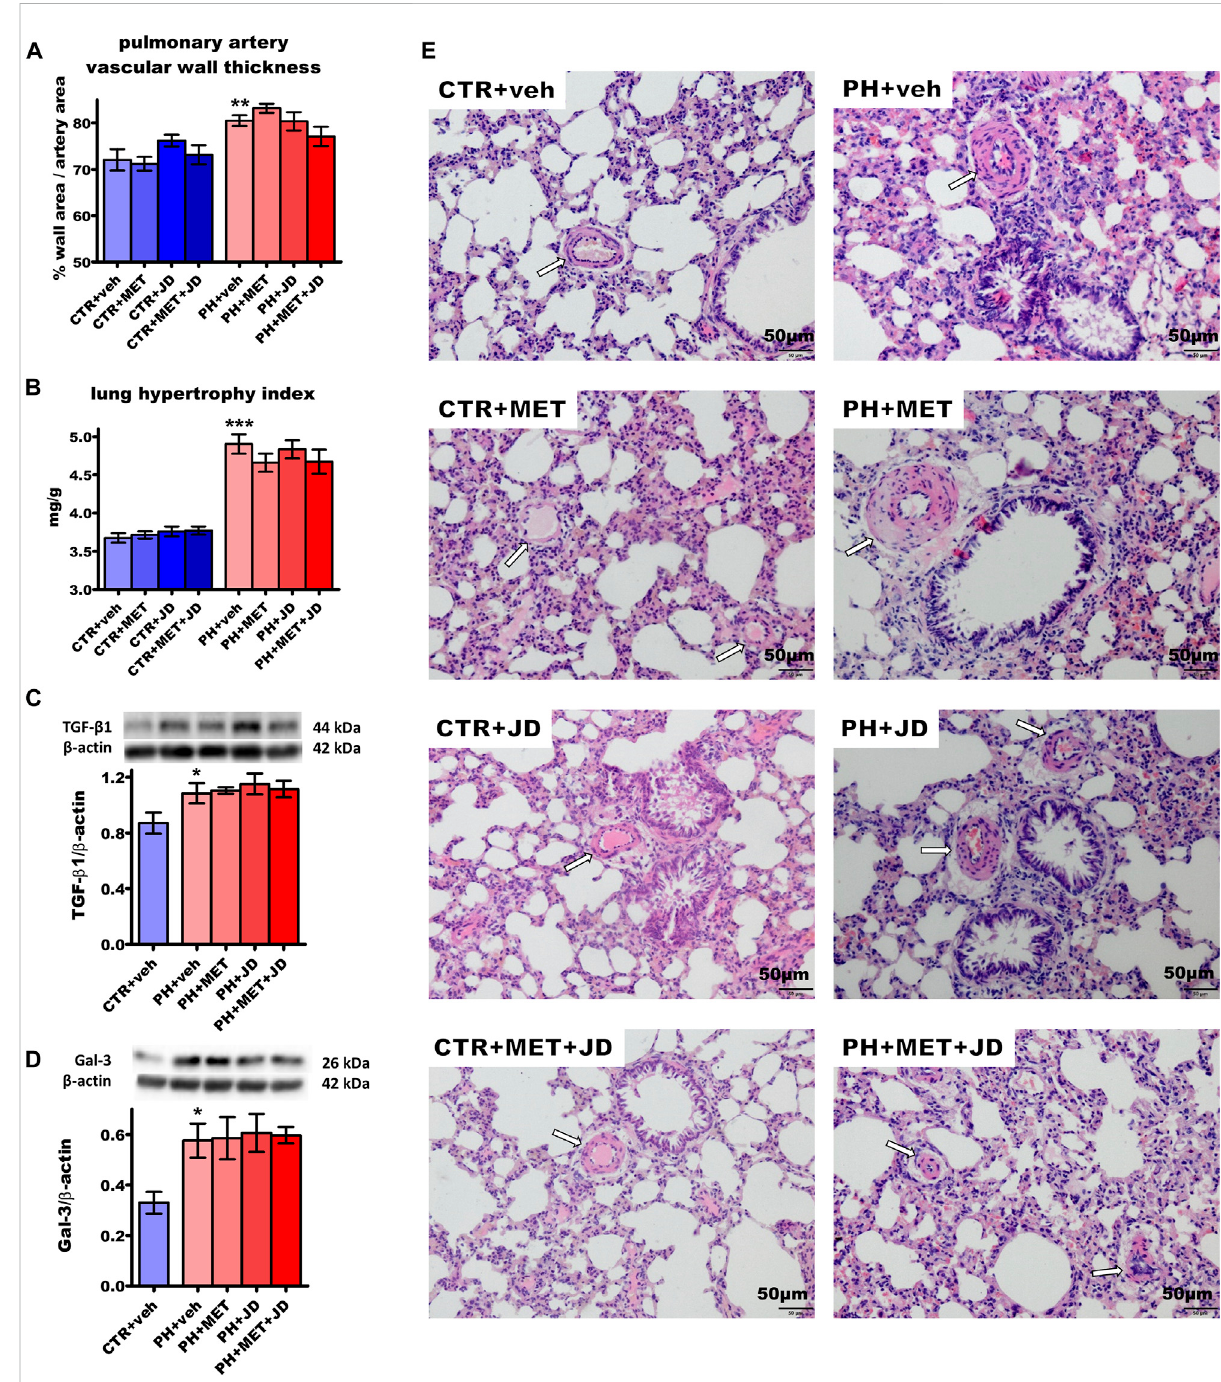
FIGURE 3 In fl uence of pulmonary hypertension, metformin (MET), JD5037 (JD) and/or their combination on pulmonary remodeling in monocrotaline- induced pulmonary hypertensive (PH) rats and their normotensive controls (CTR). (A) pulmonary artery vascular wall thickness, (B) lung hypertrophy index (expressed as lung weight to body weight) and expressionof (C) transforming growth factor β 1 (TGF- β 1) and (D) galectin-3 (Gal-3) determined byWesternblot(WB)technique, (E) representativehematoxylinandeosin-stainedlungimages(200xmagni fi cation). β -actinservedasaloading control in WB. Arrows on images show the location of the vessels. MET (100 mg/kg), JD5037 (3 mg/kg) or their combination were administered by oralgavageoncedailyfor21 days;controlsreceivedvehicles(veh)instead.Dataareexpressedasmean±SEM; n =9 – 20 (A – B) , n =5 (C,D) ;* p < 0.05; ** p < 0.01; *** p < 0.001 signi fi cantly different from CTR +